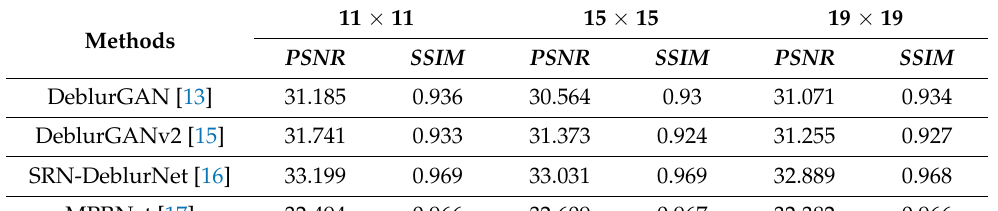
Table 7. Comparisons of motion and optical blur restoration performance of PolyU-DB by state-of- the-art methods and proposed RMOBF-Net (11 × 11, 15 × 15, and 19 × 19 mean the size of Gaussian blur filter).